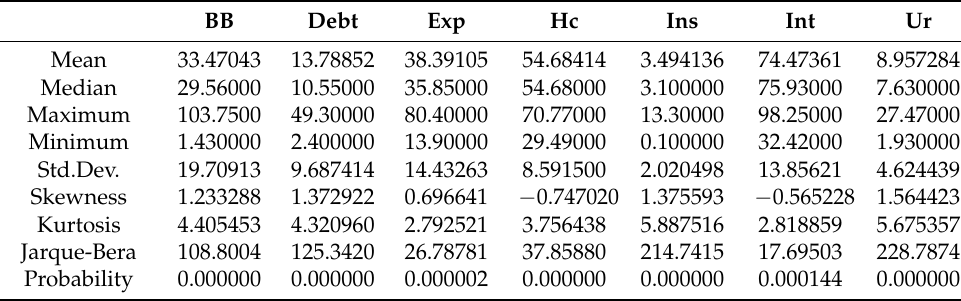
Table 3. Descriptive statistics of all EU member states